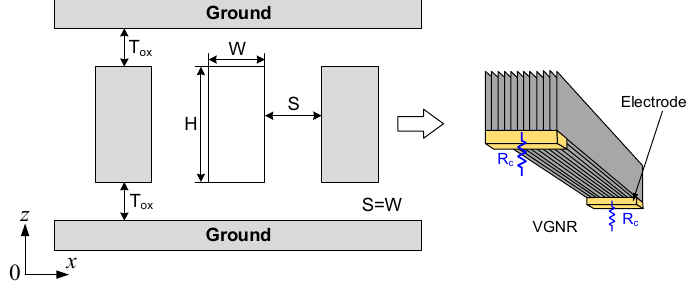
Figure 6. Schematic of vertical graphene nanoribbon (VGNR) interconnect.